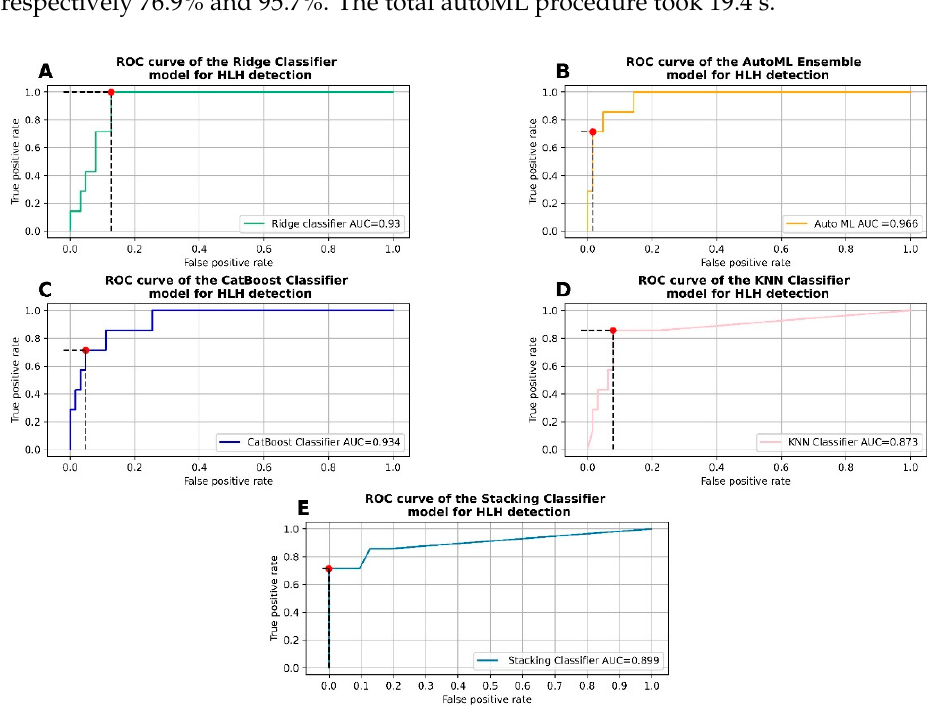
Table 3. Performance metrics on the test data for the five different algorithms used for HLH detec- tion. The highest metric value for each model is displayed in bold type. AutoML- Ensemble Model Tuned Ridge Classifier